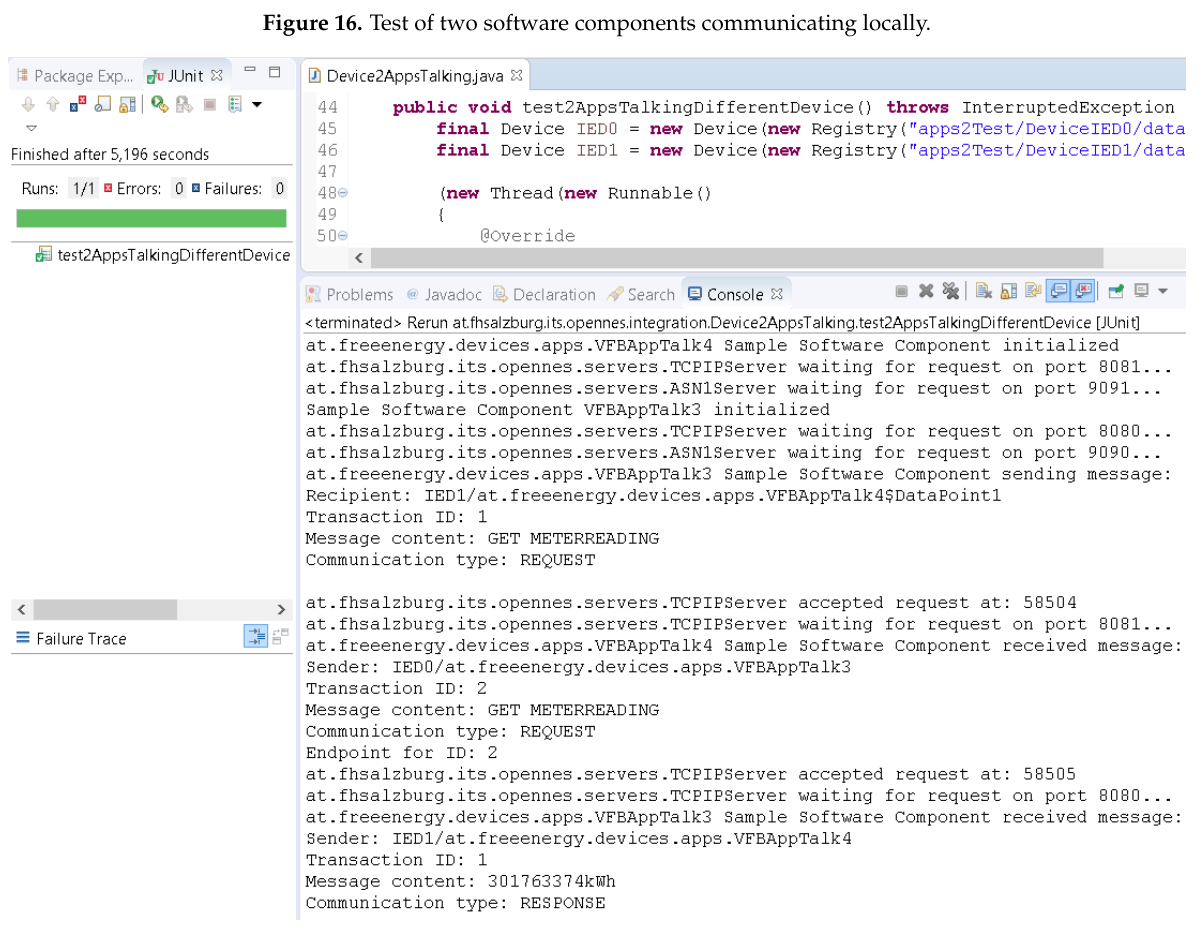
Figure 17. Test of two software components communicating